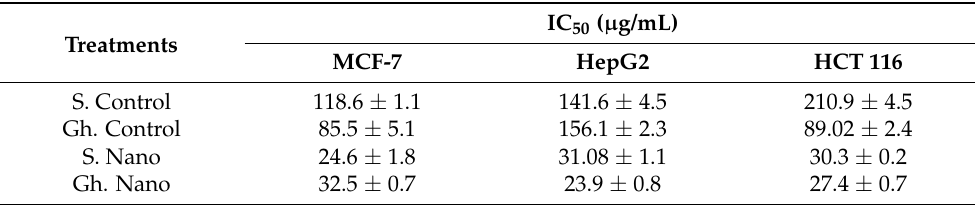
Table 2. The IC 50 s of honey (Gh = Forest and S = Sider) and honey and nanoparticles for MCF-7, HePG2, and HCT 116 human tumor cells.